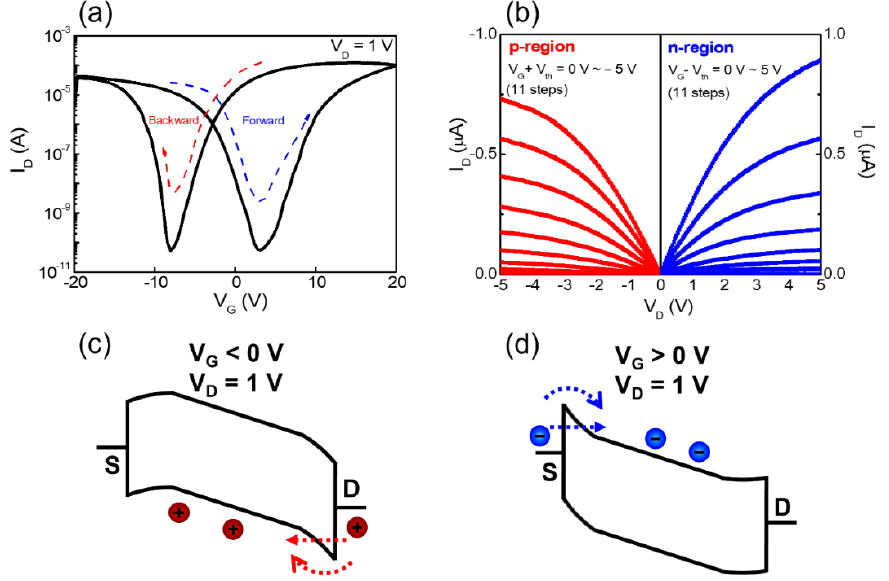
Figure 4. ( a ) Double-sweep transfer (I D − V G ) curves swept from forward to backward at V D = 1 V and ( b ) output curves (I D −V D ) in each of the p- and n-region. Current flow mechanism in ( c ) p-region and ( d ) n-region, respectively.